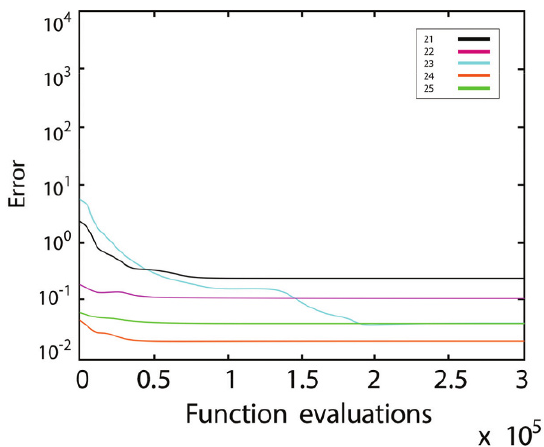
Figure 12. The results of applying the MSCA on F 11 – F 15 (Conver- gence of Functions F 11 – F 15 ).